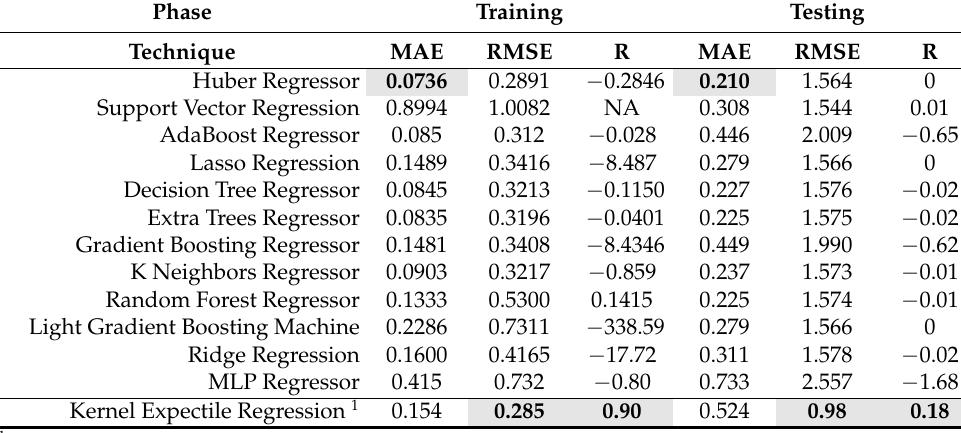
Table 8. The benchmark regression-based approaches used to predict indirect nitrogen emissions. Phase Training Testing Technique MAE RMSE Support Vector